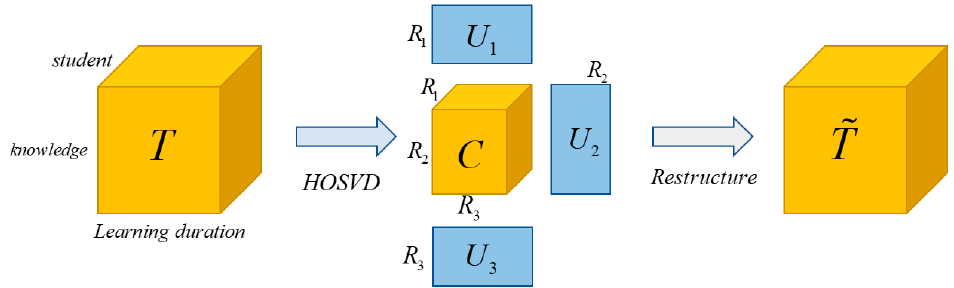
Figure 3. Visualization of third-order tensor HOSVD .